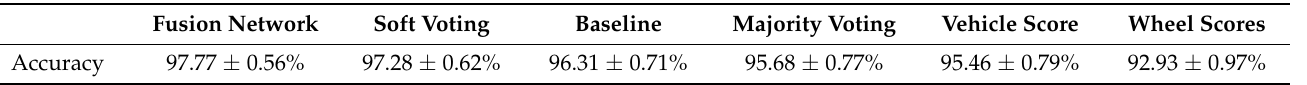
Table 8. Comparison between fusion methods and no fusion on a portion of the testing